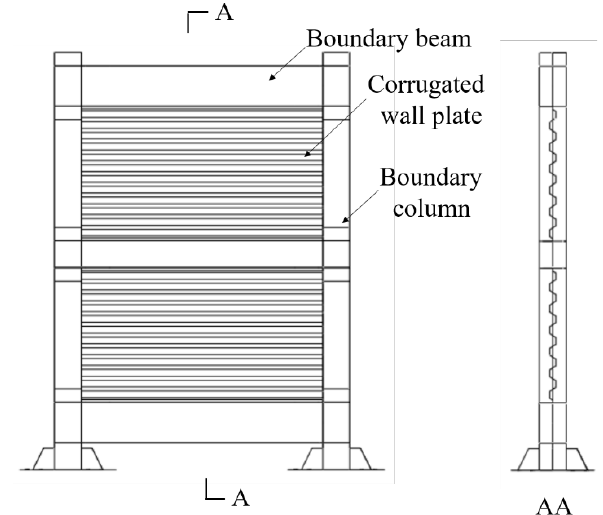
Figure 1. Corrugated steel plate shear wall.